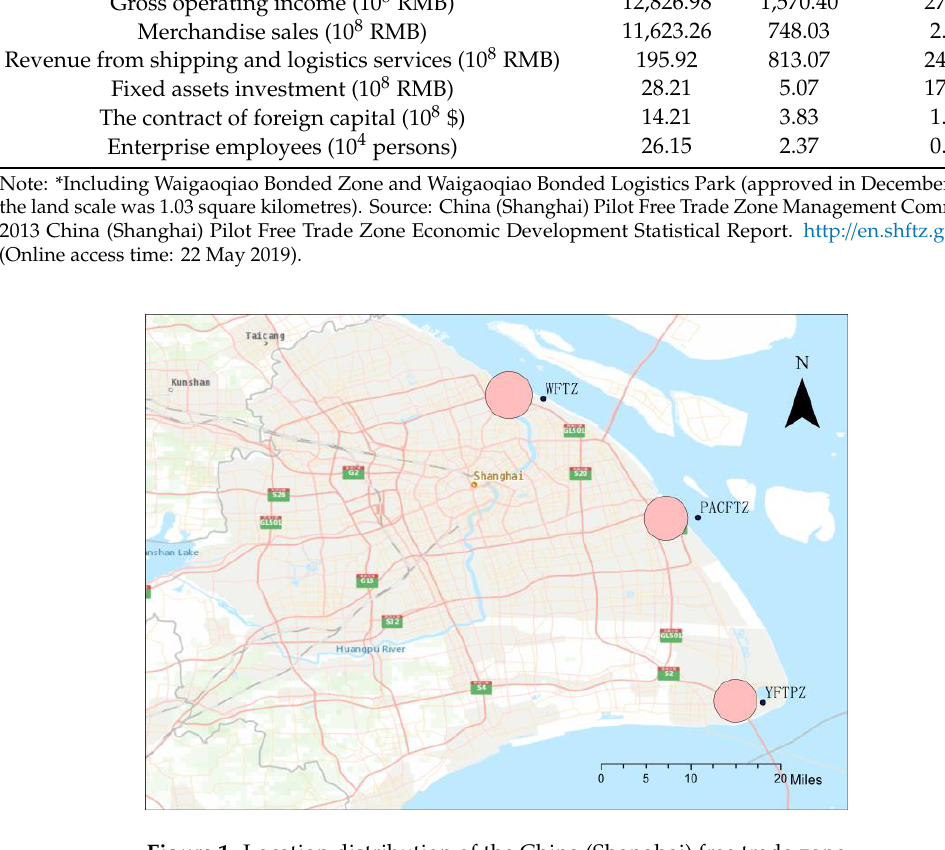
Table 2. Evaluation index system of intensive land use in the SPFTZ.